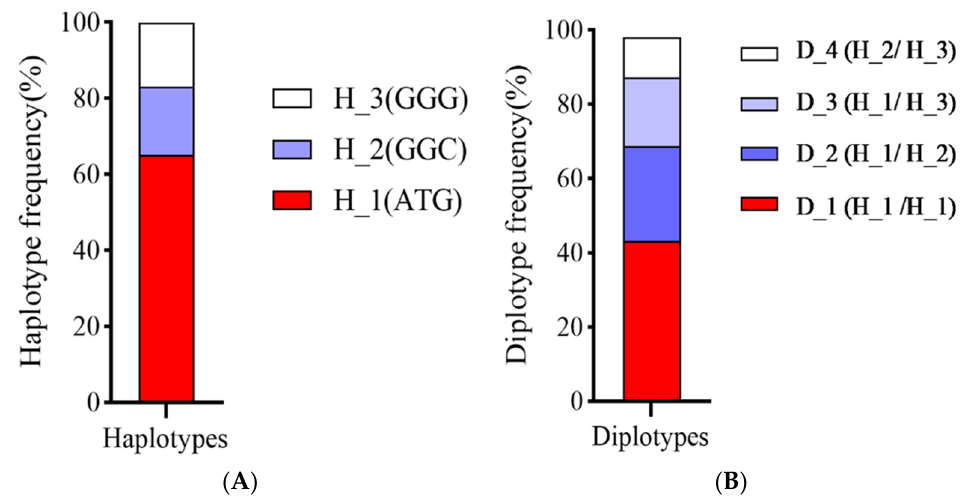
Figure 5. Frequency distribution of GHRb gene haplotypes and diplotypes in the striped catfish population. ( A ). The construction and frequency distribution of three haplotypes. ( B ). The composition and frequency distribution of four diplotypes.